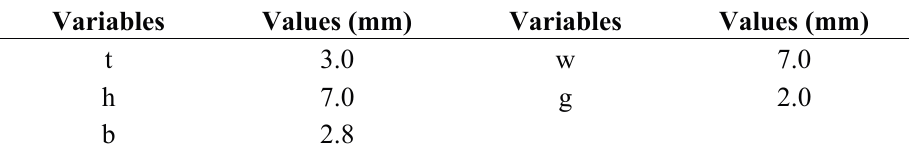
Table 1. Specifications of the Hall sensor module